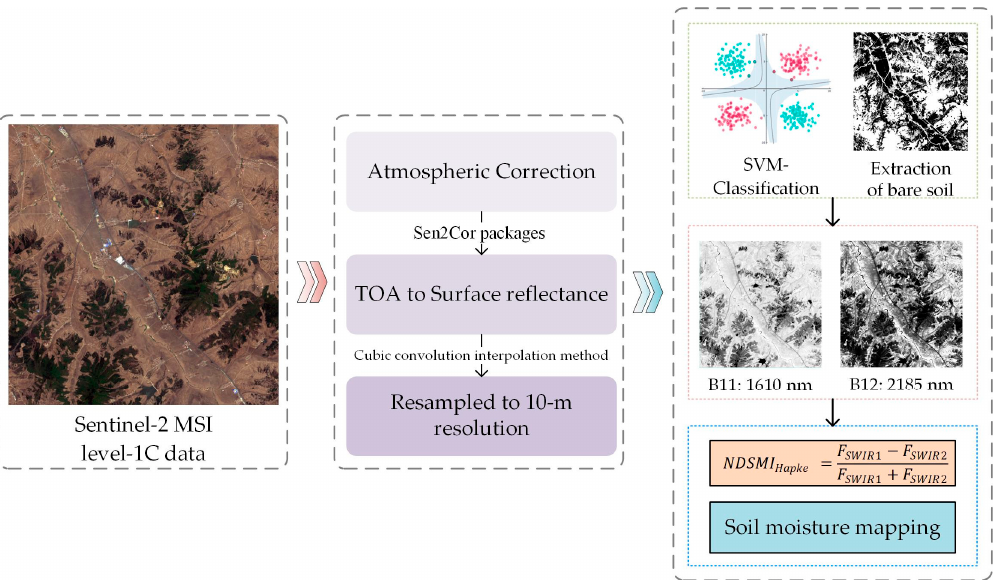
Figure 8. Flowcharts illustrating the sequence of Sentinel–2 MSI data analyses steps for mapping surface soil moisture content with NDSMI Hapke